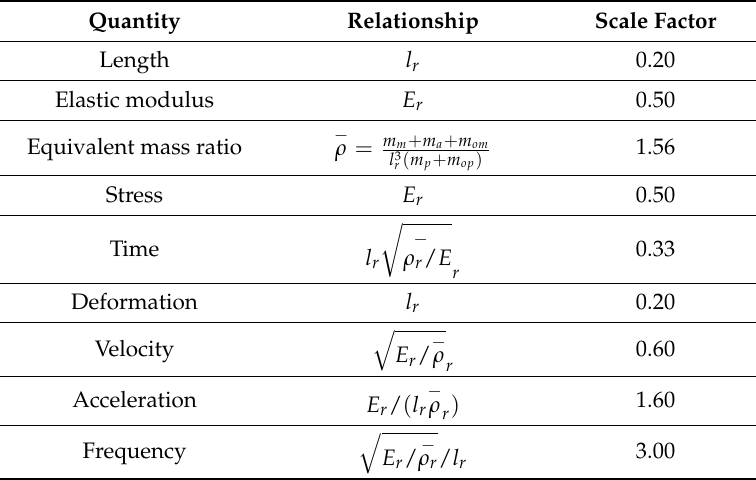
Table 3. Scale factors of the test